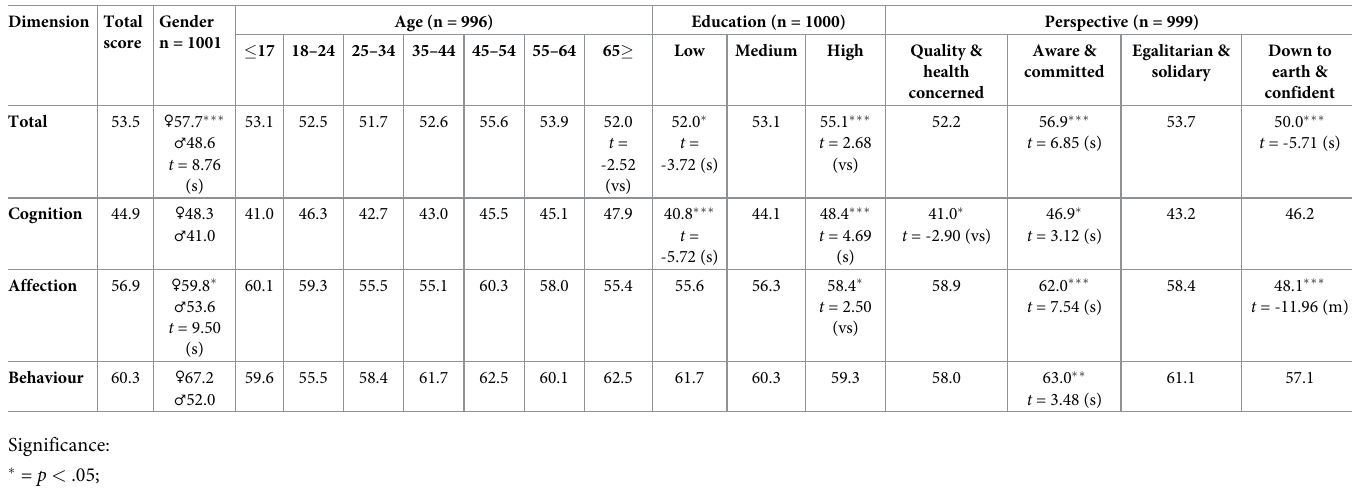
Table 4. Customer dimension awareness